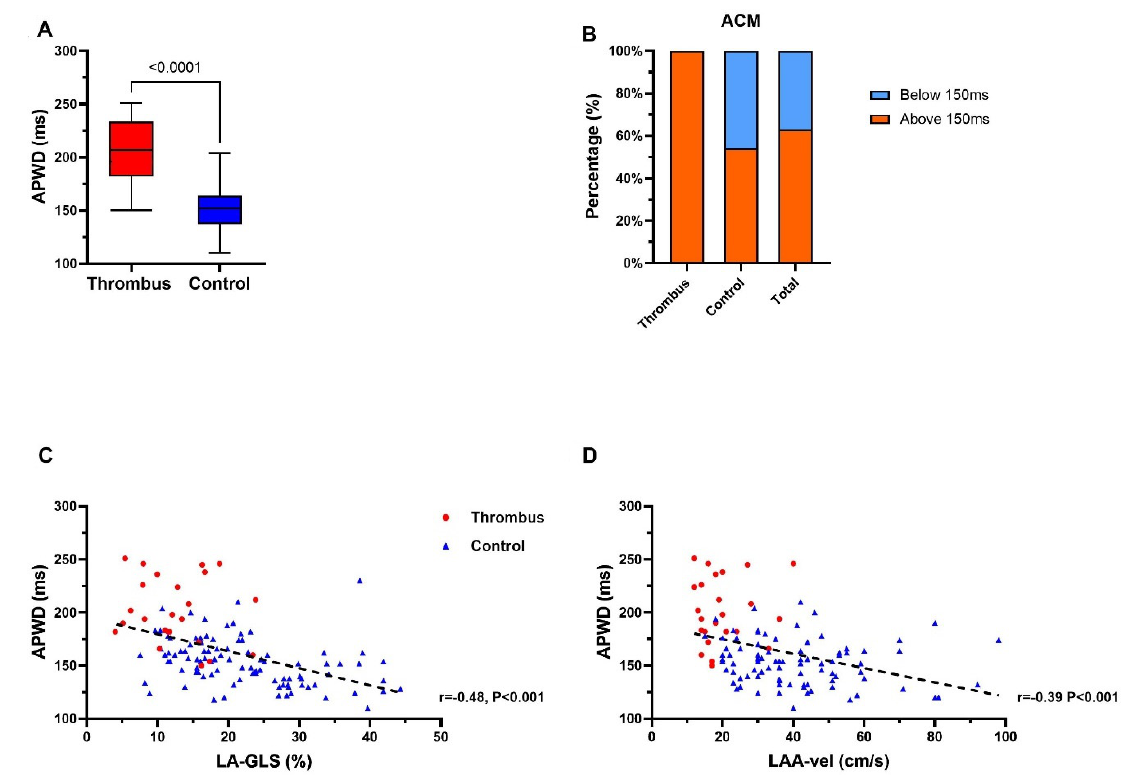
Figure 3. Assessment of electrocardiographic parameter for thrombus and ACM identification in thrombus group and control group. ( A ) demonstrates APWD in thrombus- (red) and control-group (blue). ( B ) illustrates ACM identification using the previously established threshold for detection of ACM of ≥ 150 ms (APWD below 150 ms (blue) are considered negative for ACM, patients with APWD ≥ 150 ms (red) are considered positive for ACM). ( C , D ) display the correlation (black dashed line) between APWD and LA-GLS, and APWD and LAA maximal flow velocity, respectively. ACM, atrial cardiomyopathy; APWD, amplified sinus-p-wave duration; LA-GLS, left atrial global longitudinal strain; LAA, left atrial appendage; LAA-vel, left atrial appendage maximal flow velocity. Table 3. Diagnostic value of